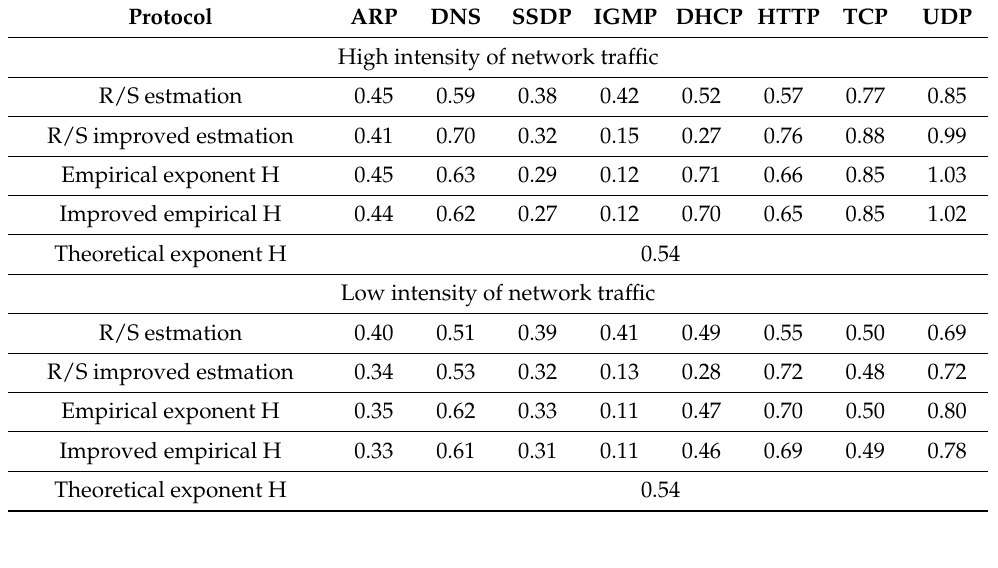
Table 8. Average Hurst coefficients for selected protocols for two types of network traffic.